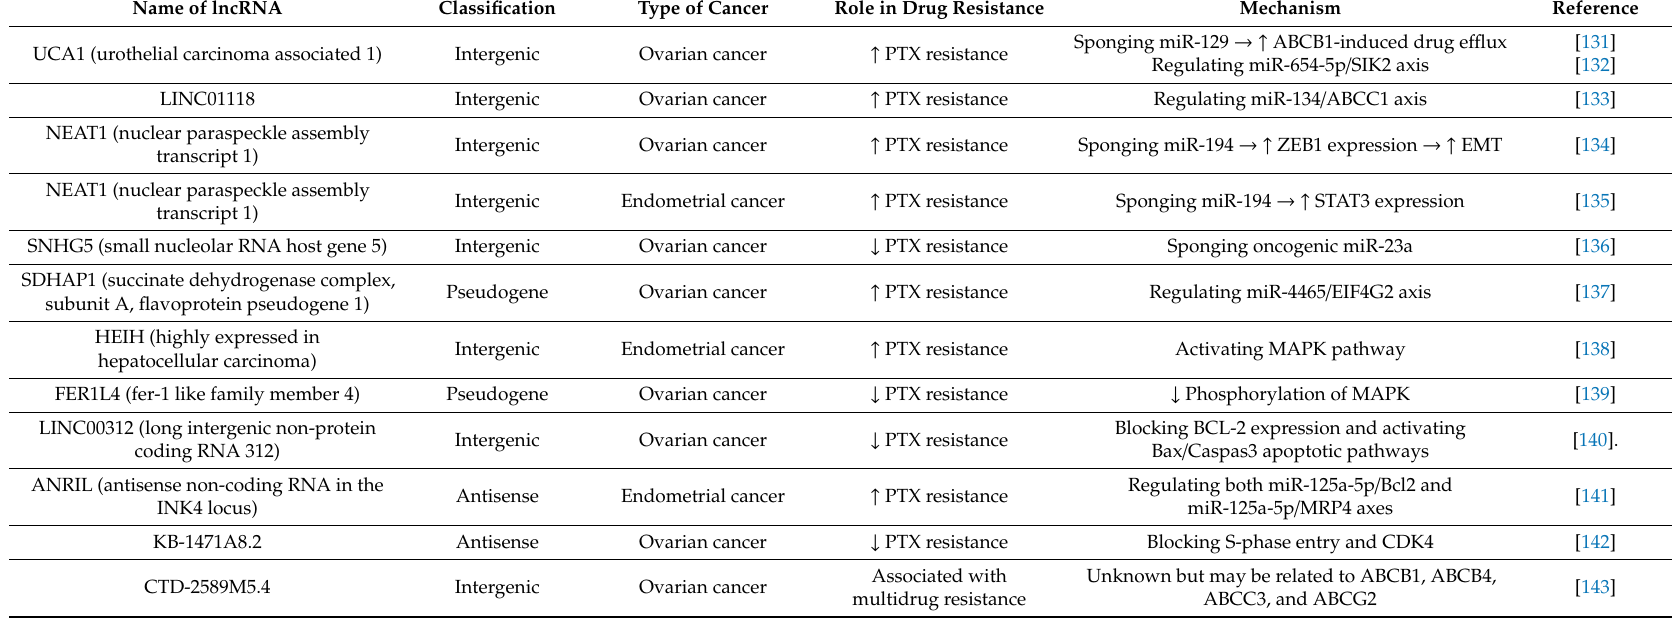
The arrows in this table refer to: ↑ (increase); ↓ (decrease); → (leading